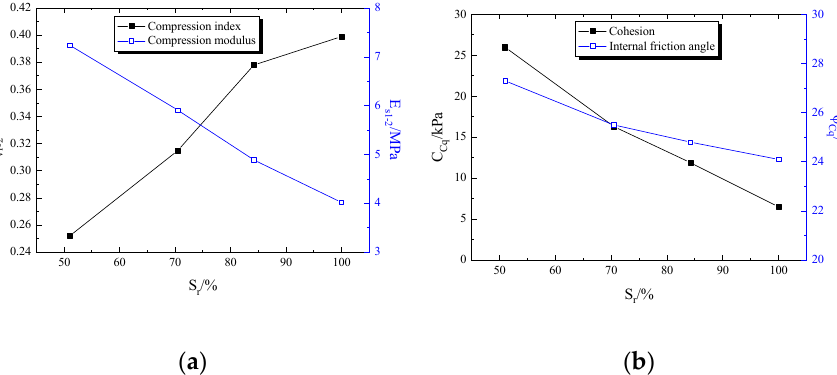
Figure 2. Variation curve of LTC1 − 1 sample: ( a ) compression index with saturation; ( b ) consolidation quick shear index with saturation.